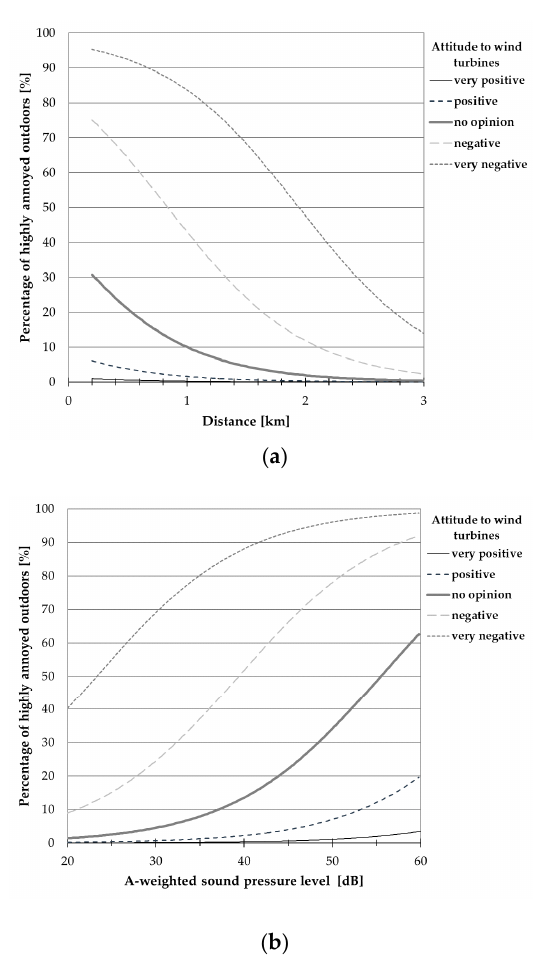
Figure 9. Percentage of respondents being highly annoyed outdoors by the wind turbine noise as a function of attitude to wind farms and ( a ) noise level or ( b ) distance from the nearest wind turbine.